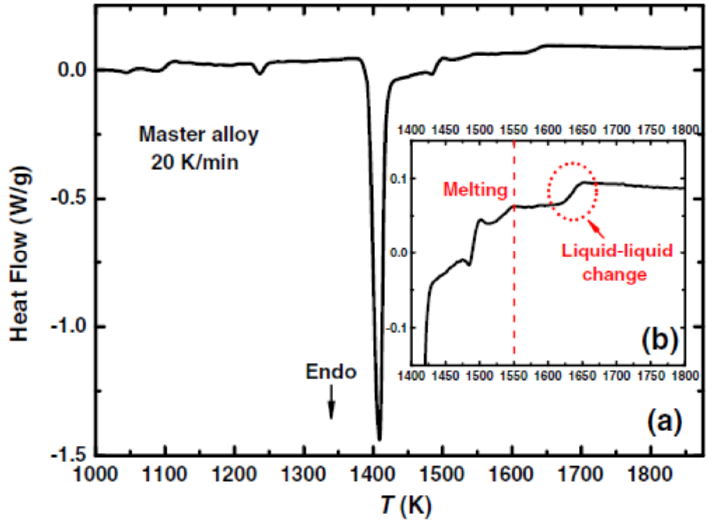
Figure 2. ( a ) High-temperature DSC trace at 0.33 K/s of the master alloy and ( b ) the enlarged version after melting. Reprinted with permission from ref. [42], Figure 7. Copyright 2014 Springer.